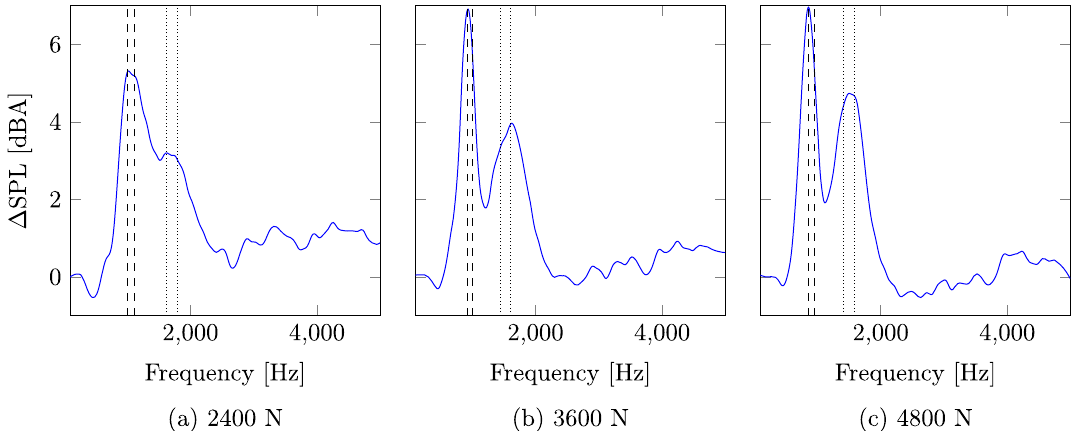
Figure 9. Comparison between the measured groove resonance ’ s spectrum and the computed groove resonance frequencies of the summer tire. The dashed lines correspond to the fi rst resonance of the inner grooves (see Fig. 8c). The dotted lines depict the second resonance of the inner grooves (see Fig. 8d).